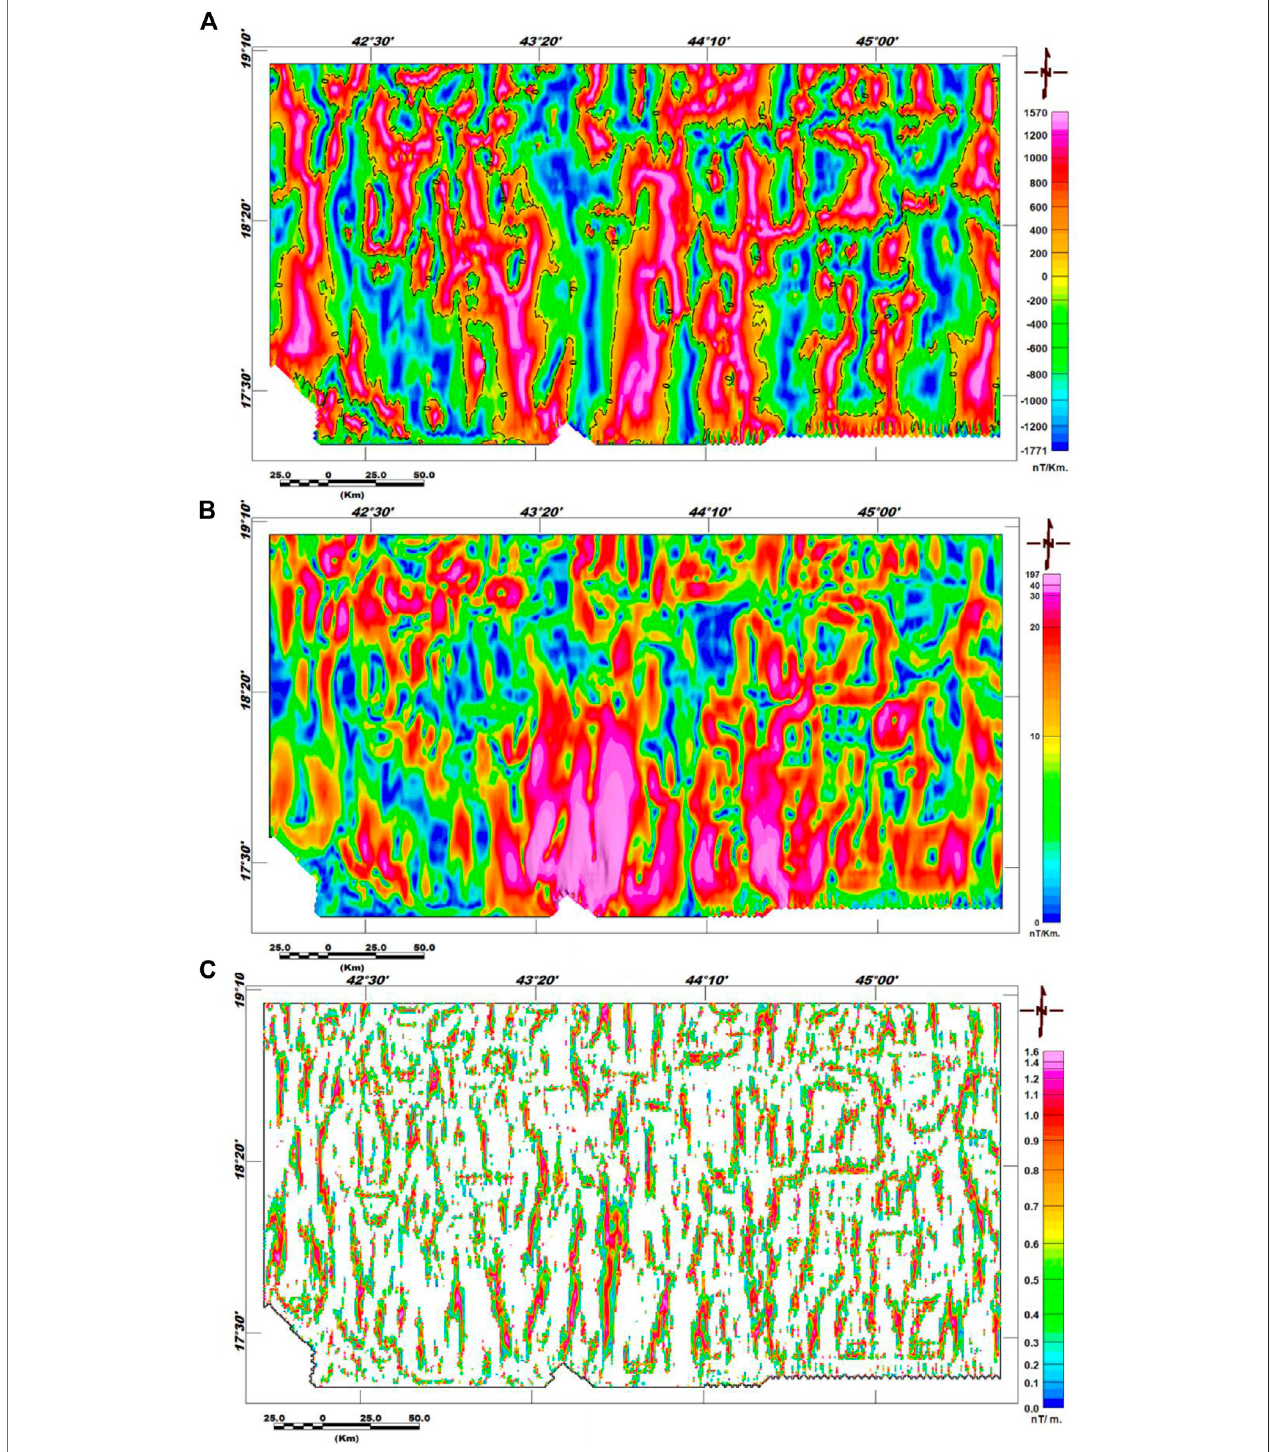
FIGURE 3 | Tilt derivative angle (A) , Total horizontal derivative (B) , and Enhanced horizontal gradient amplitude (C) maps of the study area.